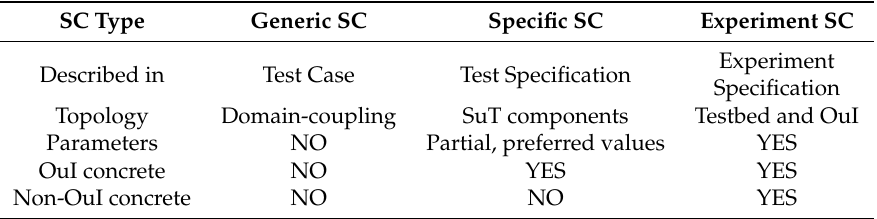
Table 1. Overview of System Configuration